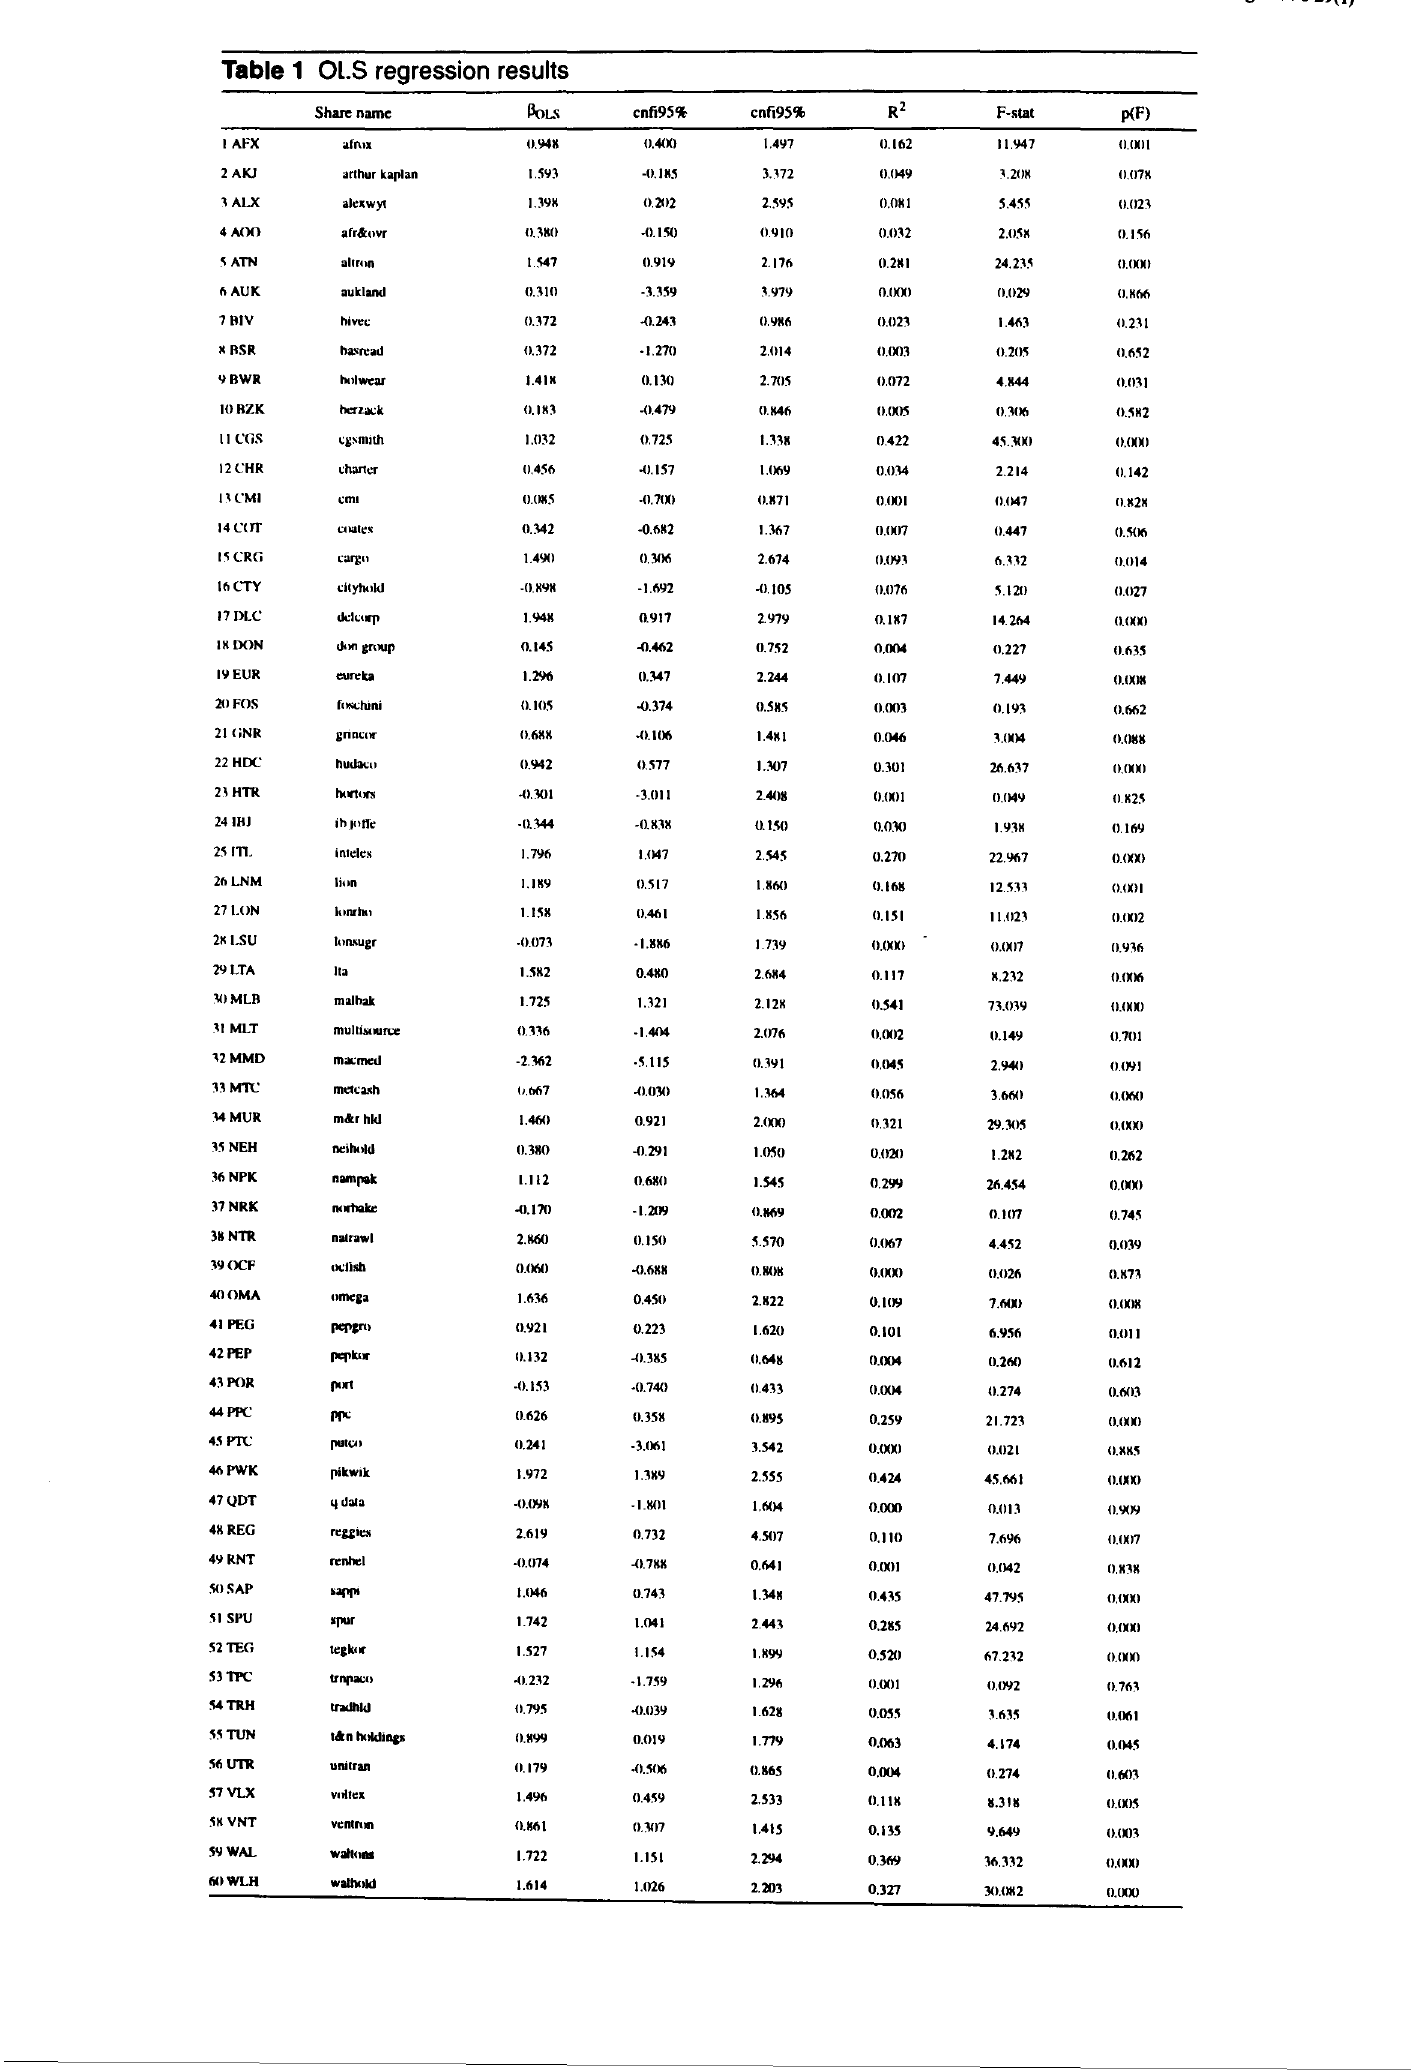
Table 1 OL.S regression